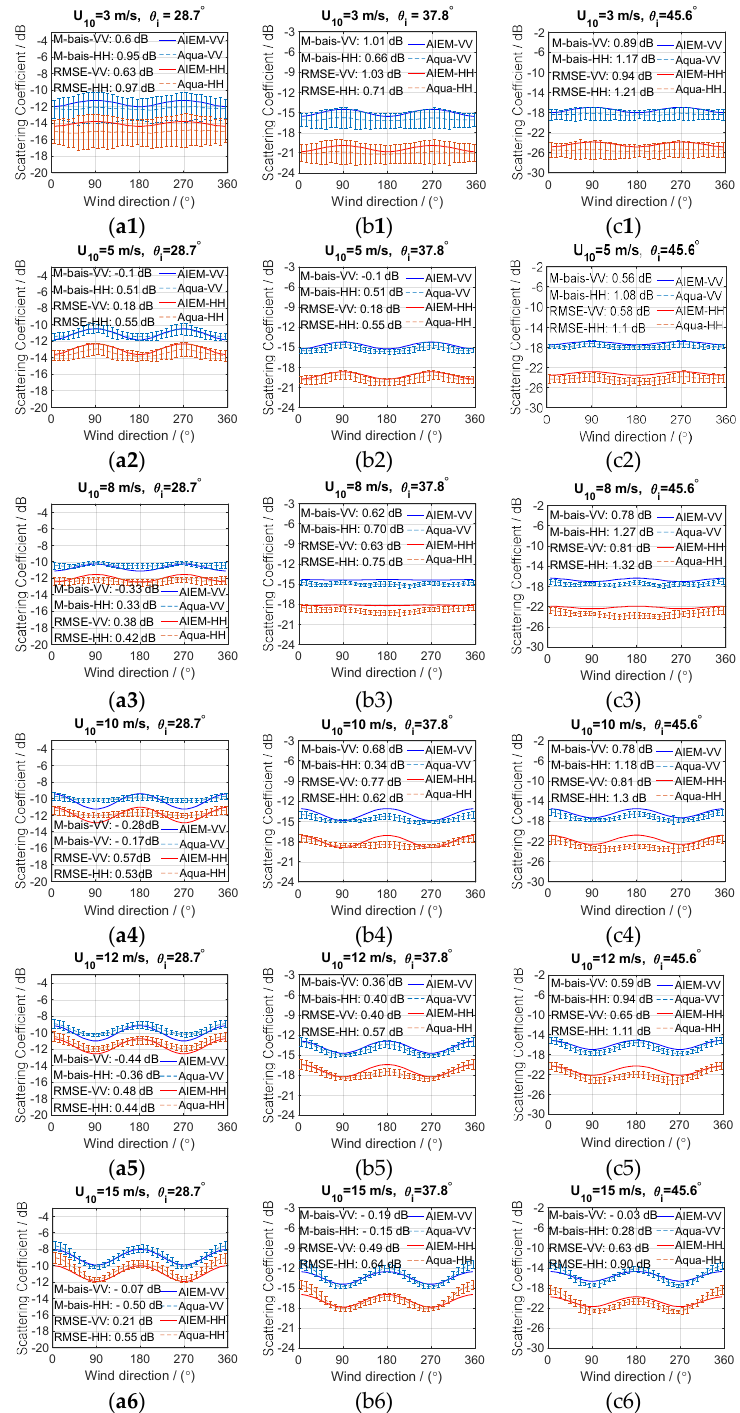
Figure 5. Comparison of simulated backscattering based on AIEM and Apel sea spectrum and Aquarius radar data at L-band for incidence angles of 28.7, 37.8, and 45.6 degrees and wind speeds of 3, 5, 8, 10, 12, and 15 m/s, respectively. ( a1 )–( c1 ) 3 m/s; ( a2 )–( c2 ) 5 m/s; ( a3 )–( c3 ) 8 m/s; ( a4 )–( c4 ) 10 m/s; ( a5 )–( c5 ) 12 m/s; ( a6 )–( c6 ) 15 m/s.